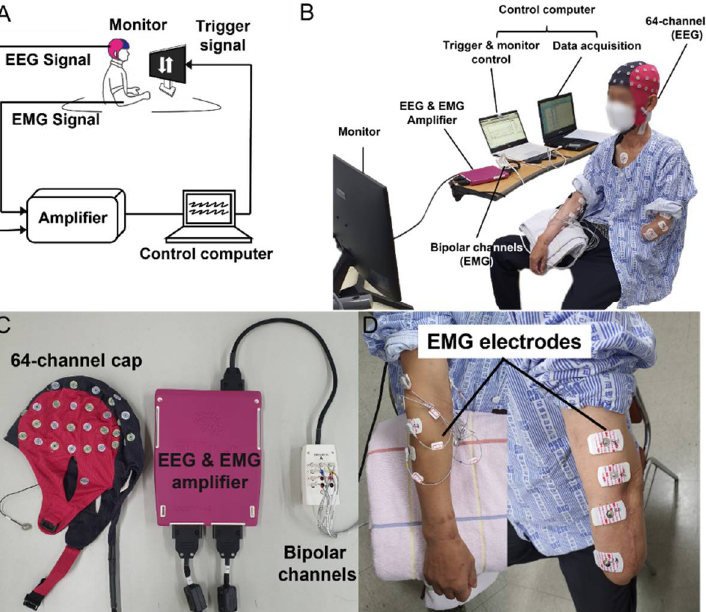
Figure 2. Experimental environment. ( A ) Schematic of experimental environment setting showing experiment flow, starting from motion of patient and continuing to data collection and storage; ( B ) Actual experimental environment and subjects wearing the experimental device, as well as data collection; ( C ) Device and sensor collecting EEG and EMG signals; ( D ) Four EMG electrodes attached to subject’s distal upper arm and another four EMG electrodes attached to proximal forearm, on intact and amputated sides,